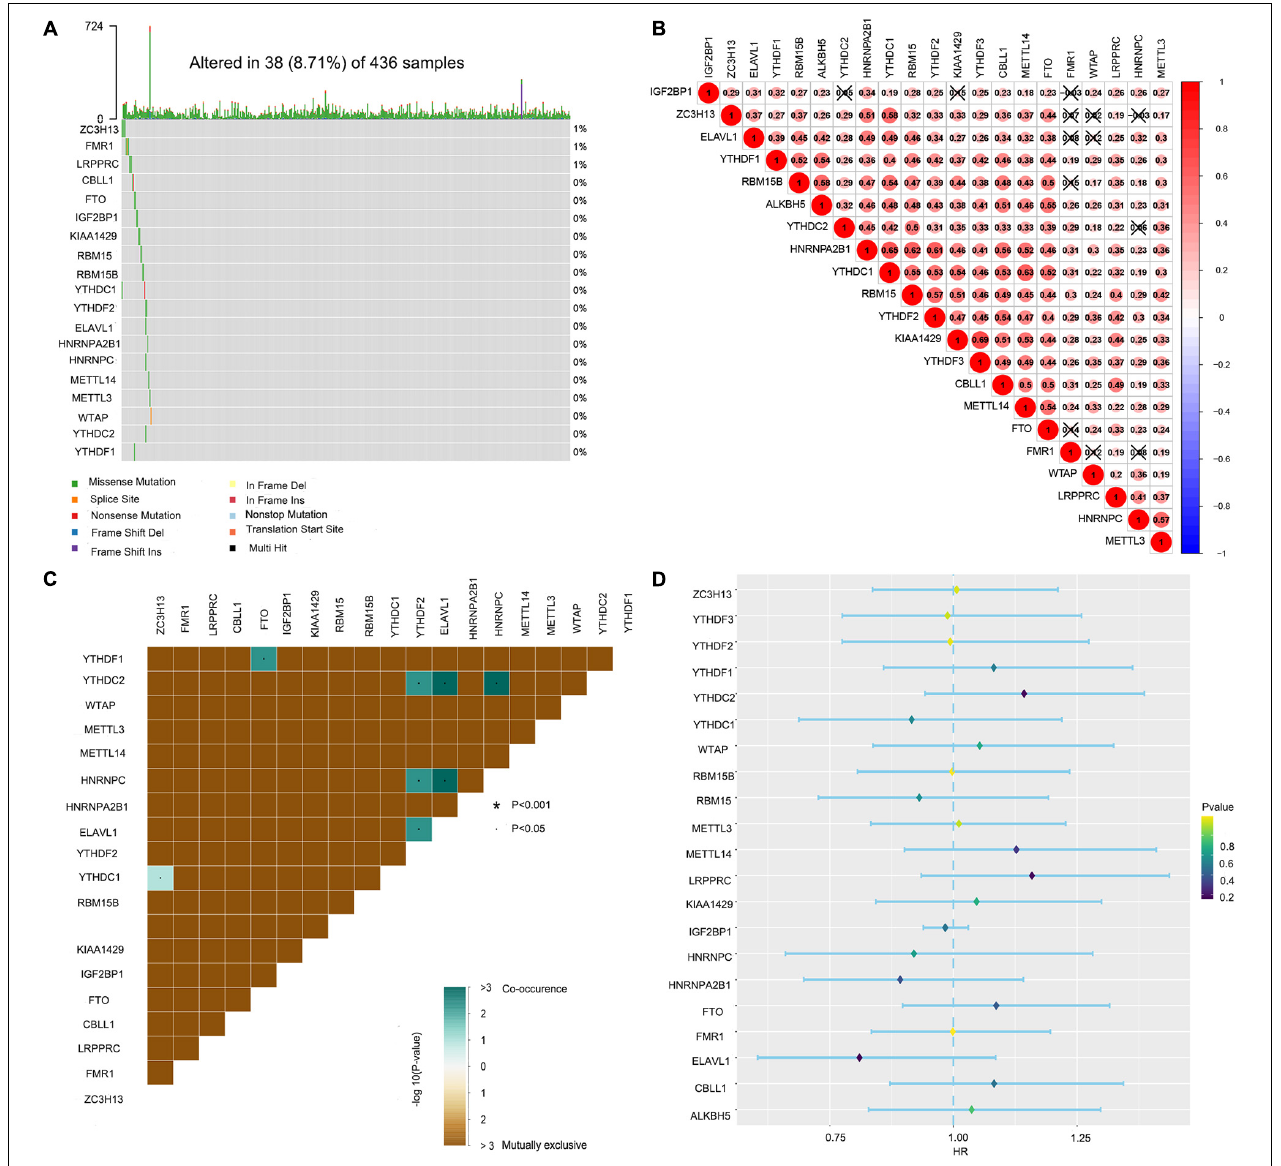
FIGURE 1 | Landscape of the 21 RNA N6-methyladenosine (m6A) regulators in ovarian cancer from The Cancer Genome Atlas (TCGA) database. (A) The mutation characteristics of the 21 m6A regulators in 436 samples from TCGA-OV dataset. (B) The correlation coefficients of the 21 m6A regulators obtained by Pearson correlation analysis. (C) The mutation co-occurrence and exclusion analyses of the 21 m6A regulators. (D) The univariate Cox regression model used to evaluate the prognostic value of the 21 m6A regulators in ovarian cancer (* P < 0.05).